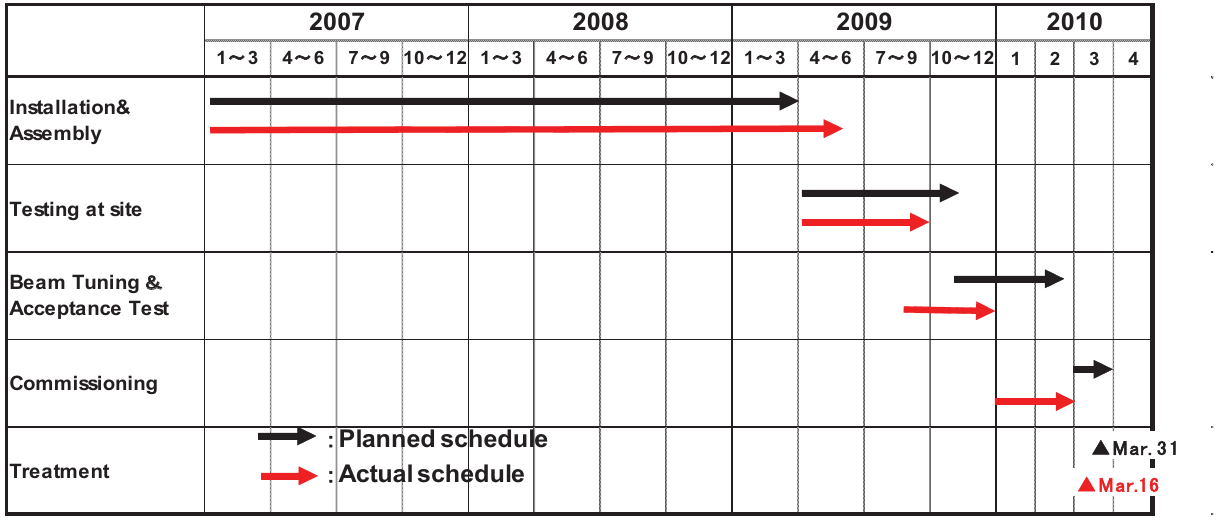
Figure 2. Planned and actual construction schedule of the treatment system at